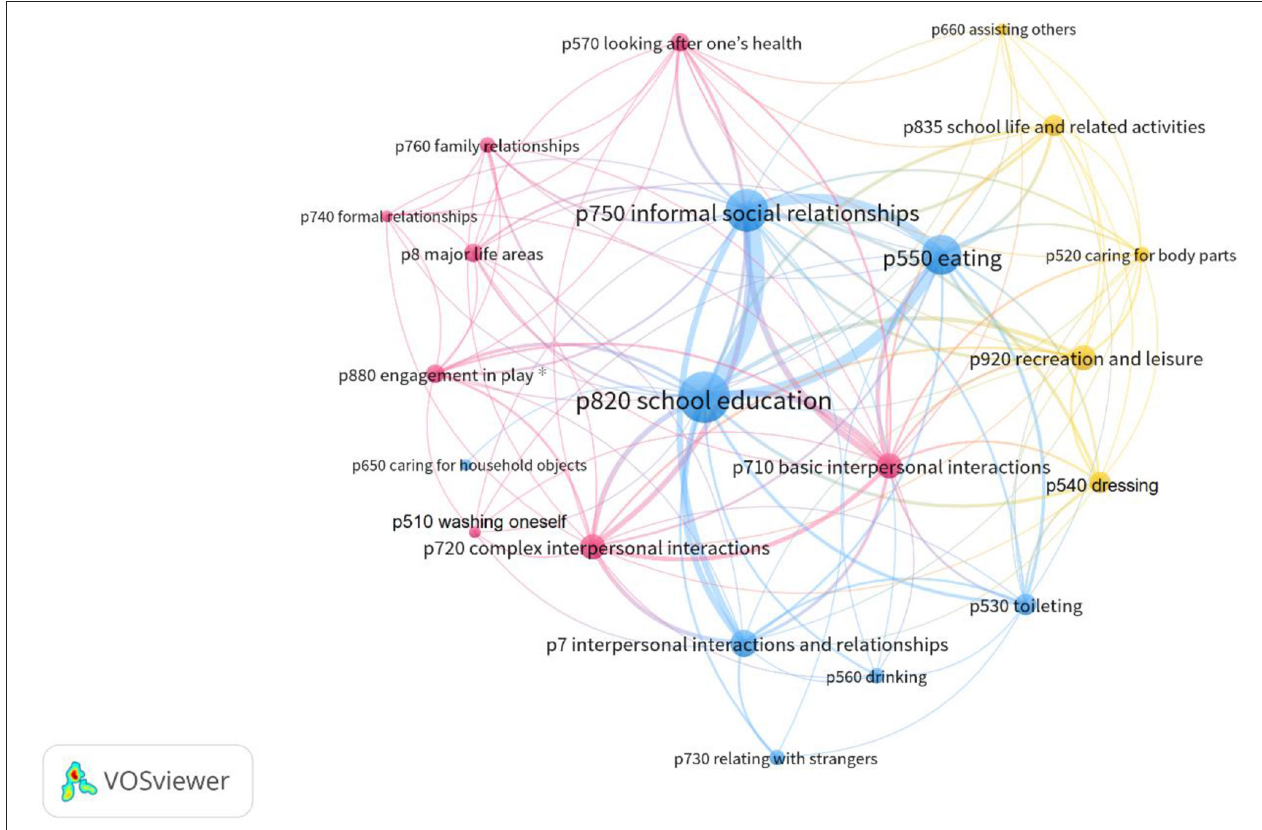
FIGURE 3 | Network visualization diagram between the participation codes. ICF p codes with labels, co-occurrence threshold = least 1 occurrence, No. of codes = 21, No. of clusters = 3. *ICF codes included in the old version of ICF-CY.